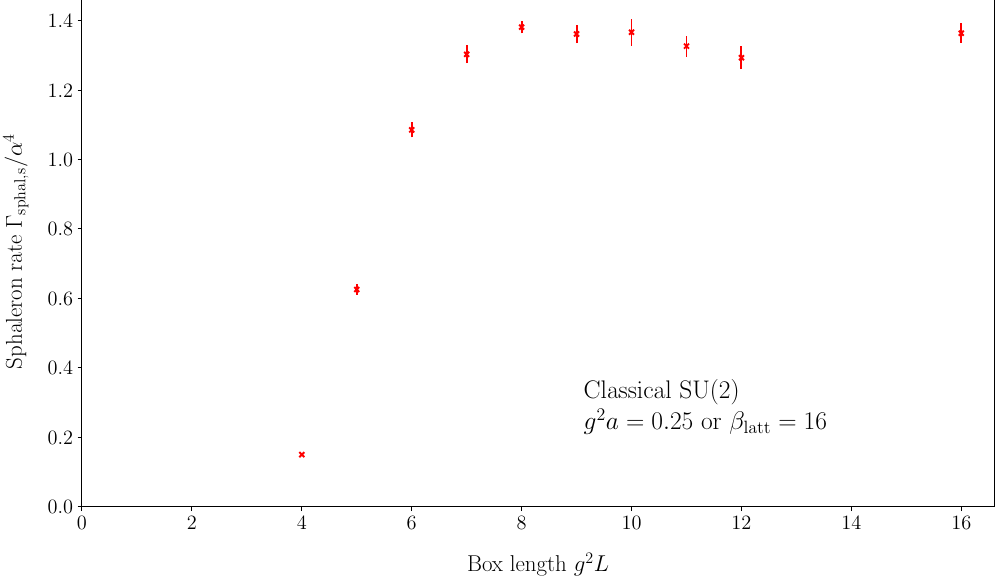
Figure 11 . Volume dependence of the SU(2) sphaleron rate when the rate is determined using classical-field, real-time techniques as in ref. [49]. As the volume increases, the rate rises and saturates to a very clear